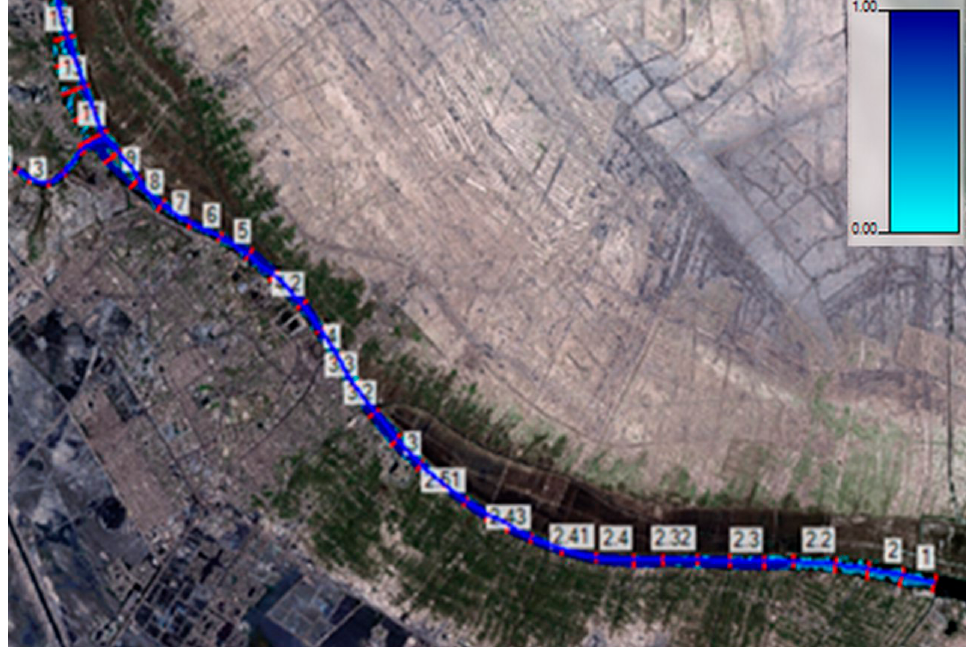
Figure 21. Flood extent generated by HEC-RAS 5.03 at the end of the wave period for case B1.